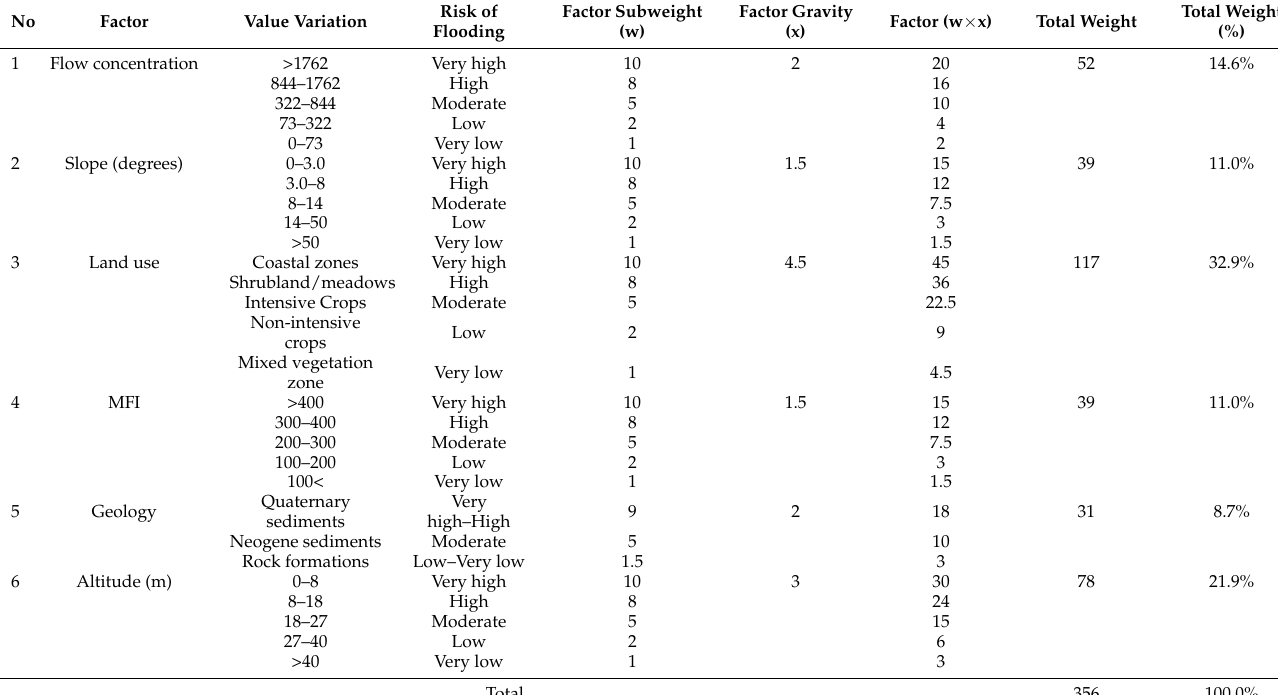
Table 1. Flood hazard factors and their characteristics, adapted from Kourgialas and Karatzas